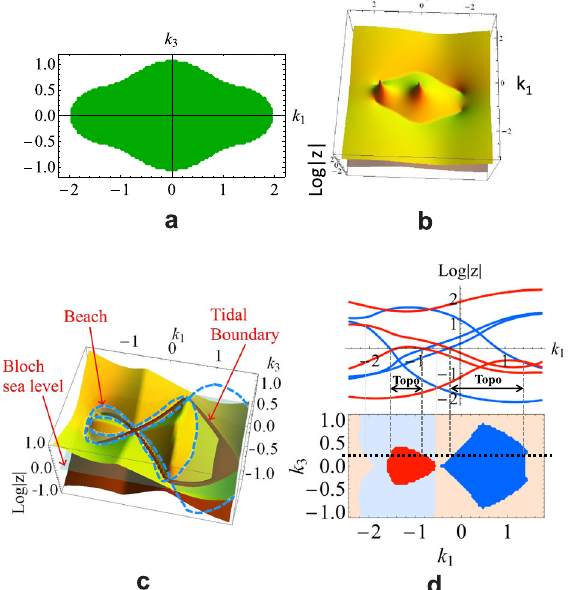
Fig. 3 Schematic illustration to relate the complex band structure, topological states, and vorticity. ( a ) For the non-Hermitian Trefoil nodal Fig. 2 Topological (tidal) surface states and imaginary gap band knot metal (NKM), 3D plot of complex energy spectrum along k 1 and with structure of the non-Hermitian nodal Hopf-link and Trefoil knot. a ^ n ¼ ^ e Topological (tidal) surface states (normal to ^ e 2 ) of the non-Hermitian nodal 2 surface, under periodic boundary conditions (PBC) and open boundary conditions (OBC) in red and blue respectively. The vorticity v Hopf-link, with the analytic expression given by Eq. (7). b , c Plot of the changes from 0 to 1/2 and then 0, as seen in the cross-section insets at k 1 imaginary gap (log j z j where z ¼ e i k 2 ) band structure across the ^ e 2 surface = 0.2, 1 and 2.2. PBC states form red tubes enclosing the two blue OBC skin Brillouin Zone (BZ) of the non-Hermitian Hopf link ( b ) and Trefoil knot ( c ). state branches, which can only meet and eliminate the topological modes The analytically obtained tidal region of (a) are exactly demarcated by the (black) when the vorticity v = 1/2. ( b ) The 3D PBC spectral plot is a trenches (tidal boundaries) in ( b ). c Topological (tidal region) boundaries segment of a Riemann surface (Bottom Left) obtained by closing the k 1 are the intersections (trenches) between its 4th (yellow) and 5th (brown) loop, with each pair of ‘ pants ’ a vorticity transition. ( c ) The topological/tidal bands. The periodic boundary conditions (PBC) spectrum gap closes along region (yellow) boundaries occur where the topological modes disappear band intersections (dashed blue beaches) with the cyan “ sea level ” surface and thus must lie in the regions with vorticity v = 1/2, which experience a ¼ (cid:2) i log z ). d Correspondence between the log j z j ¼ 0 (which has real k 2 net anticlockwise winding of u tidal phase boundaries in k 1 - k 3 space, and the r a + r b = 4 highest a i ( k ∥ ) (blue) and b i ( k ∥ ) (red) log j z j bands along an illustrative k ∥ = ( k 1 , k 3 = 0.2) line. Case 3-type intersections between the 4th and 5th bands mark tidal phase boundaries with blue (red) regions corresponding to the 4th band being a i ( b i ), shaded (lightly) brightly according to whether the topological criterion Eq. (6) is (not) satis fi ed.